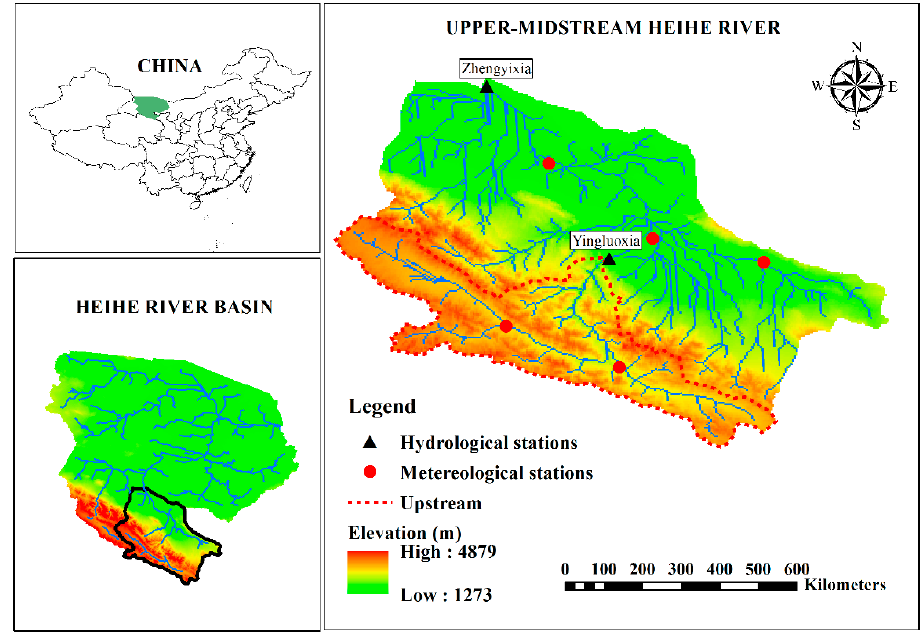
Figure 2. Hydro-meteorological stations in the upper-midstream Heihe River basin.